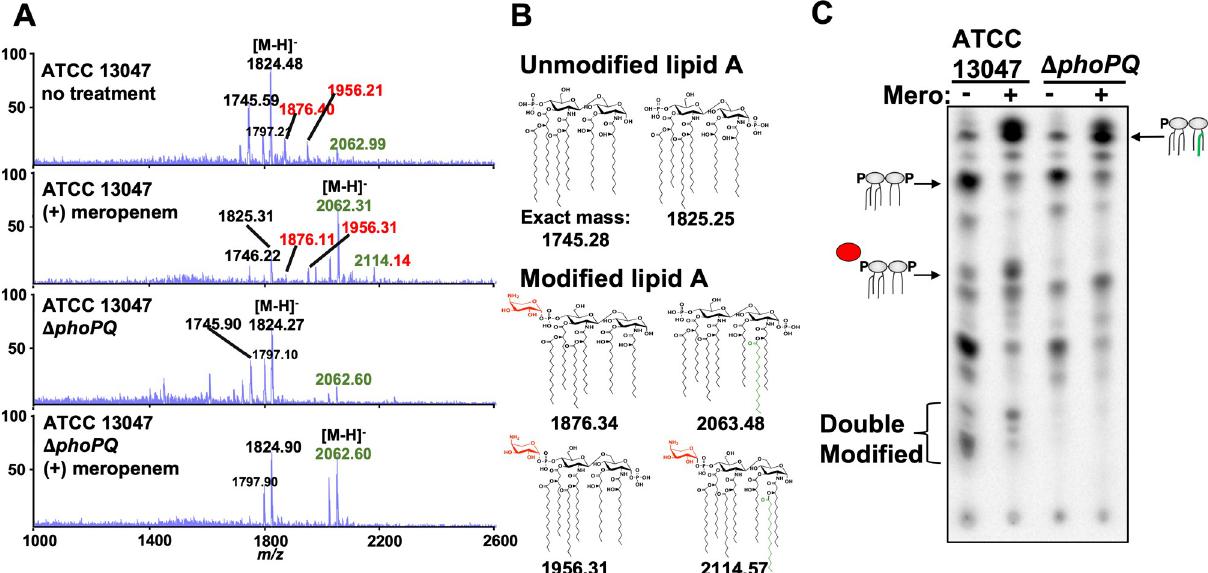
Fig 4. Analysis of E . cloacae lipid A after meropenem treatment. (A) MALDI-TOF MS analysis of lipid A extracted from wild-type or Δ phoPQ E . cloacae strains. L-Ara4N modifications are illustrated in red, while C 16:0 additions are green. Numbered labels that are both red and green contain both modifications. Each experiment was independently replicated three times, and one representative data set was reported. (B) Predicted lipid A chemical structures in wild type and Δ phoPQ E . cloacae . (C) 32 P-radiolabelled lipid A was extracted from treated or untreated wild-type or Δ phoPQ E . cloacae . Lipids were separated based on hydrophobicity using thin-layer chromatography. Red circle denotes L-Ara4N modification, while the green line indicates C 16:0